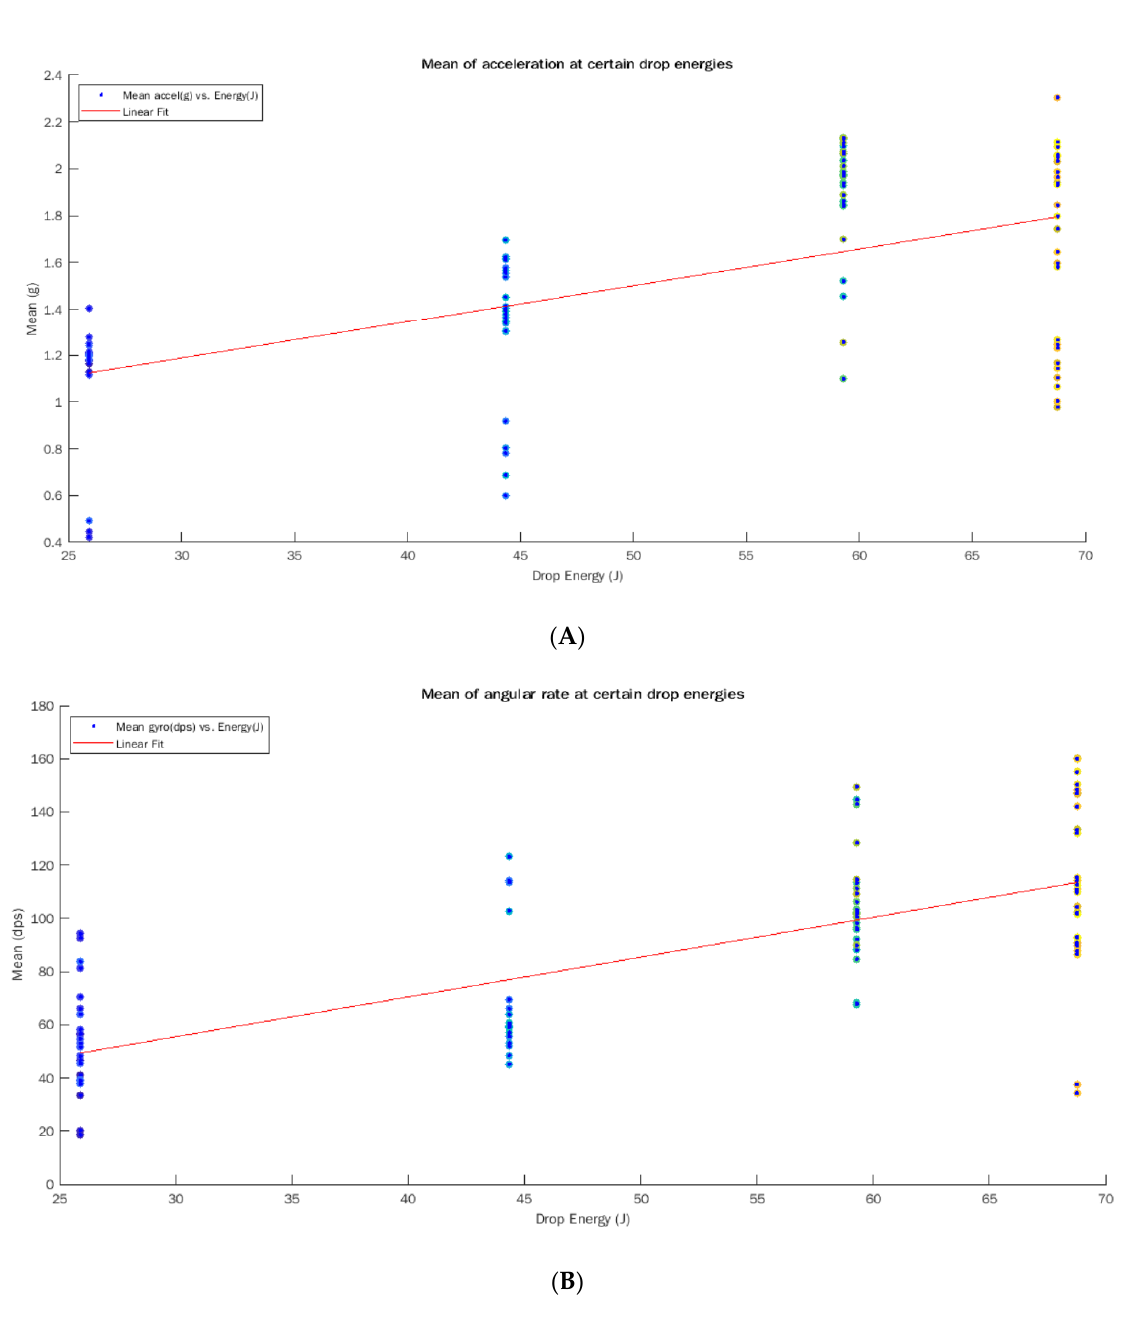
Figure 3. This figure shows all 101 signals with the linear curve for acceleration ( A ) and rotational rate ( B ) at 4 different heights of 0.67 m, 1.13 m, 1.5 m, and 1.75 m. Figure 5 displays two example signals number 3 and number 13 ( x -axis only). Signal 3 is from the IMU placed on the hand and signal 13 is from the IMU placed on the head while the jab is performed. The circled areas were of interest and an explanation is provided in the